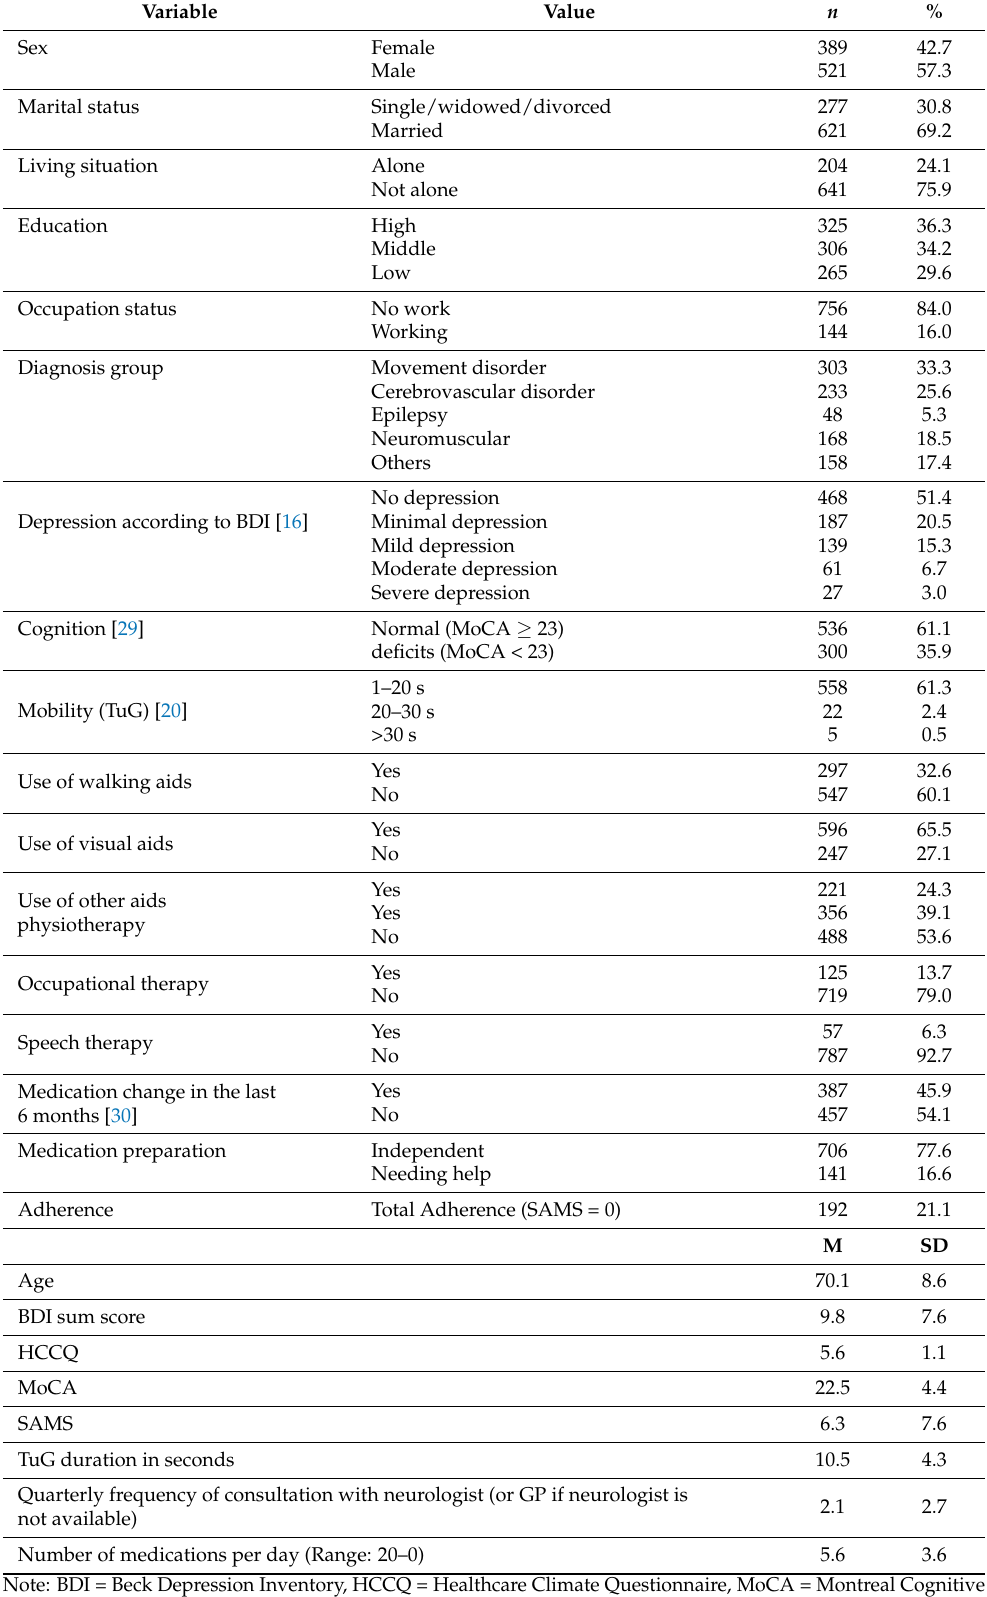
Table 1. Clinical and demographical